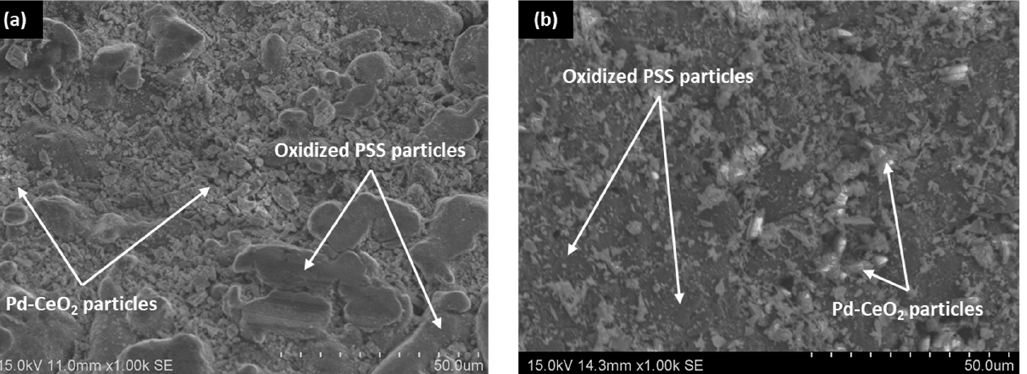
Figure 4. SEM micrographs of Pd–CeO 2 intermediate layer reached on contrary sides of calcined PSS supports: ( a ) external and ( b ) internal.